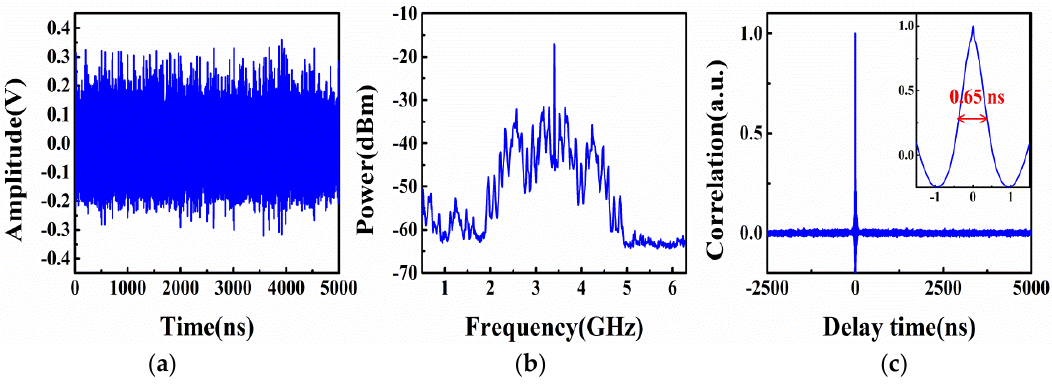
Figure 1. Properties of the transmitted signal. ( a ) Time series; ( b ) Power spectrum; ( c ) Autocorrelation trace.